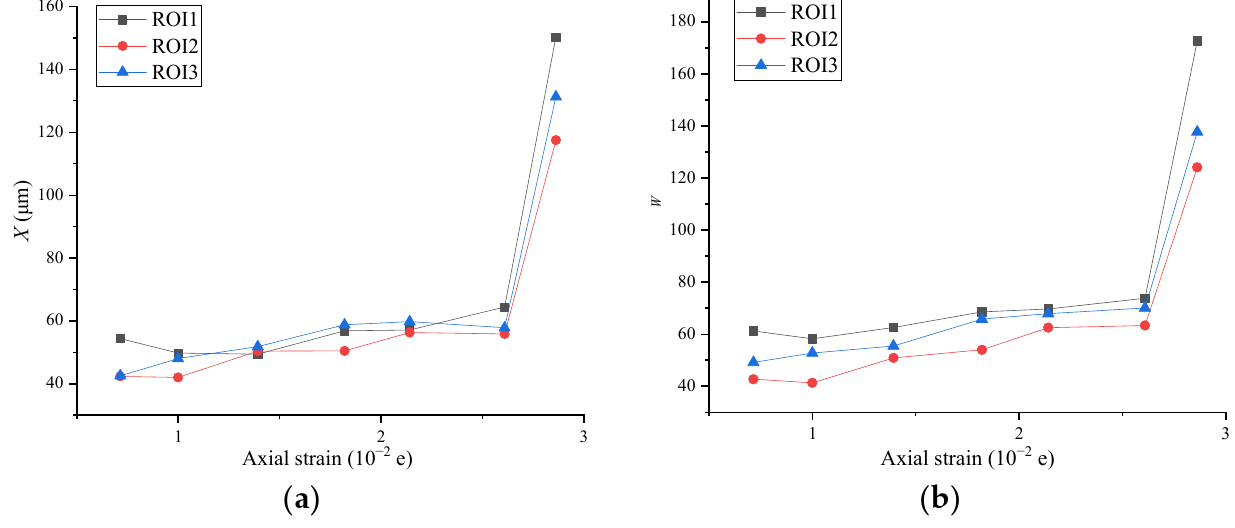
Figure 11. Statistical results for the ROI3 displacement field at different stages (stage 2 to 8).